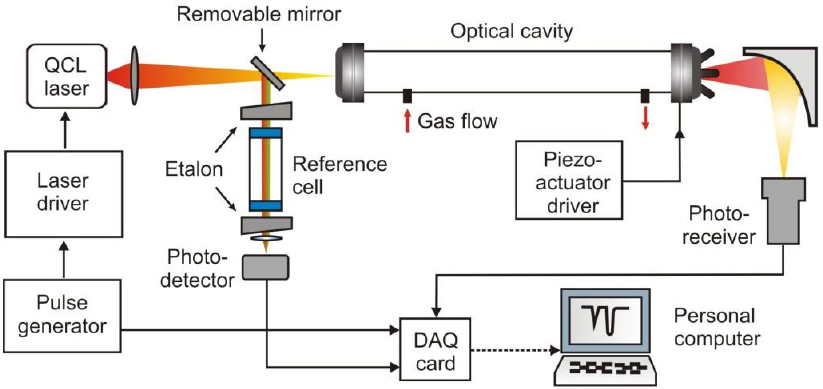
Figure 13. Operation principles of ICOS